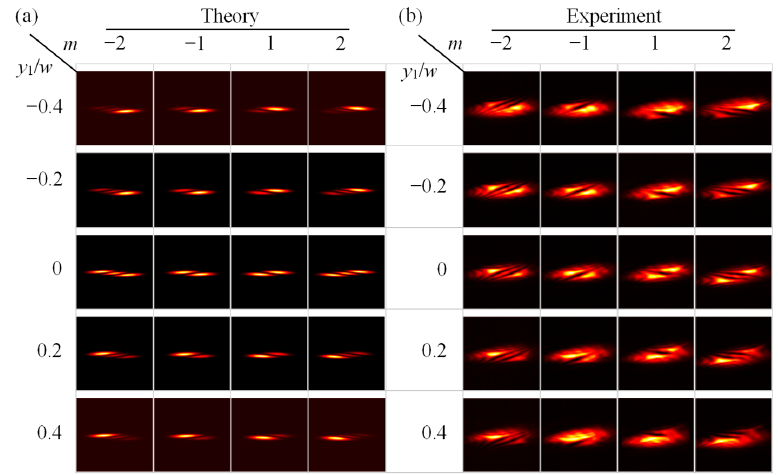
Figure 6. ( a ) Theoretically simulated and ( b ) experimentally measured intensity patterns of off-axis single vortex beams with different values of y 1 and m focused by a tilted convex lens, when λ = 1064 nm, w = 2.5 mm, f = 30 cm, z 0 = 50 cm, z = 28 cm, θ = 21°, and x 1 = 0.